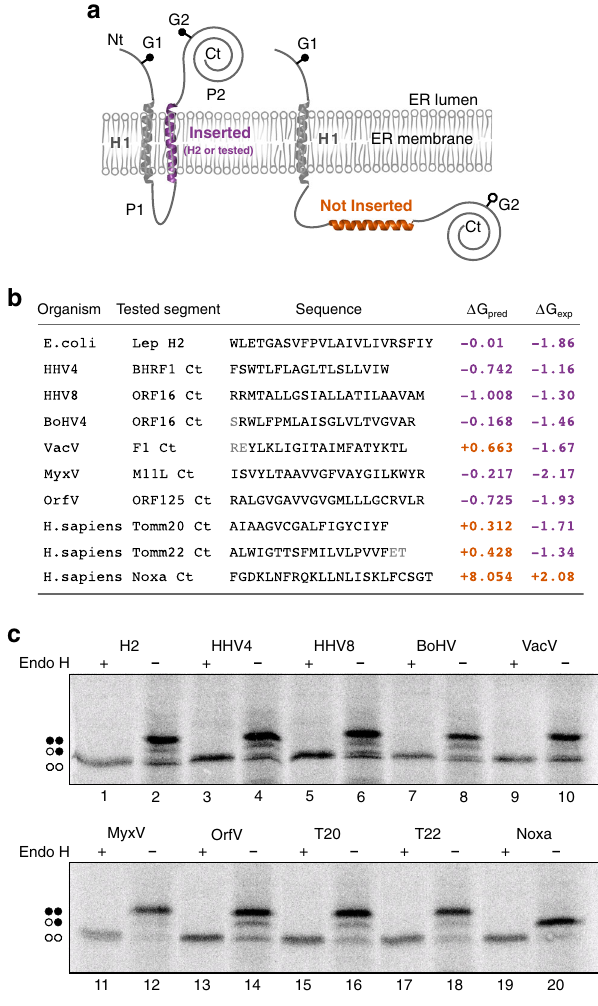
Fig. 1 Insertion of vBcl2 Ct hydrophobic sequences in eukaryotic membranes. a A schematic representation of the leader peptidase (Lep) model protein. G1 and G2 denote arti fi cial glycosylation acceptor sites. The sequence under investigation was introduced replacing the H2 domain of Lep. Recognition of the tested sequence as a TMD by the translocon machinery (highlighted in purple) results in the modi fi cation of the G1 and G2 acceptor sites. The Lep chimera will be singly glycosylated if the sequence being tested is not recognized as a TMD and thus not inserted into ER-derived membranes (shown in orange). b The sequences (including name and organism of origin) used in the assay are shown alongside their predicted Δ G ( Δ G pred ) in kcal/mol, calculated using the Δ G prediction server in its Δ G prediction mode. Residues shown in gray were not considered by the Δ G prediction server. Additionally, the experimental Δ G s in kcal/mol ( Δ G exp ), calculated based on the ratios between mono and double glycosylated populations, are presented in the right column. Experimental results are the average of at least four independent experiments. Purple numbers indicate negative Δ G s (insertion of the tested sequence), while orange numbers denote Δ G values above 0. c A representative example ( n = 4) of an in vitro protein translation in the presence of ER-derived microsomes and in the presence ( + ) or absence ( − ) of Endoglycosydase H (EndoH), a glycan-removing enzyme. The absence of glycosylation of G1 and G2 acceptor sites is indicated by two white dots, single glycosylation by one white and one black dot, and double glycosylation by two black